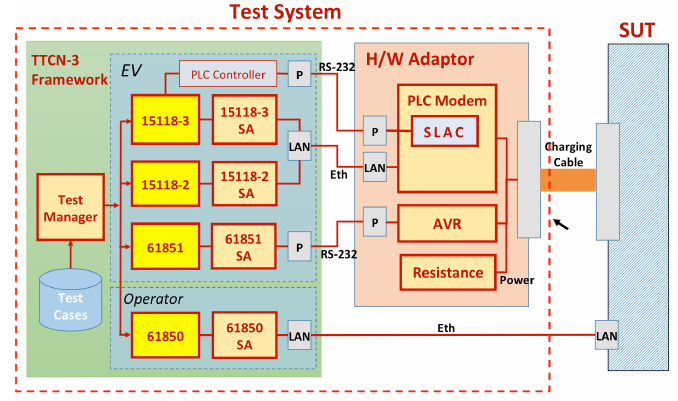
Figure 7. The architecture of the test